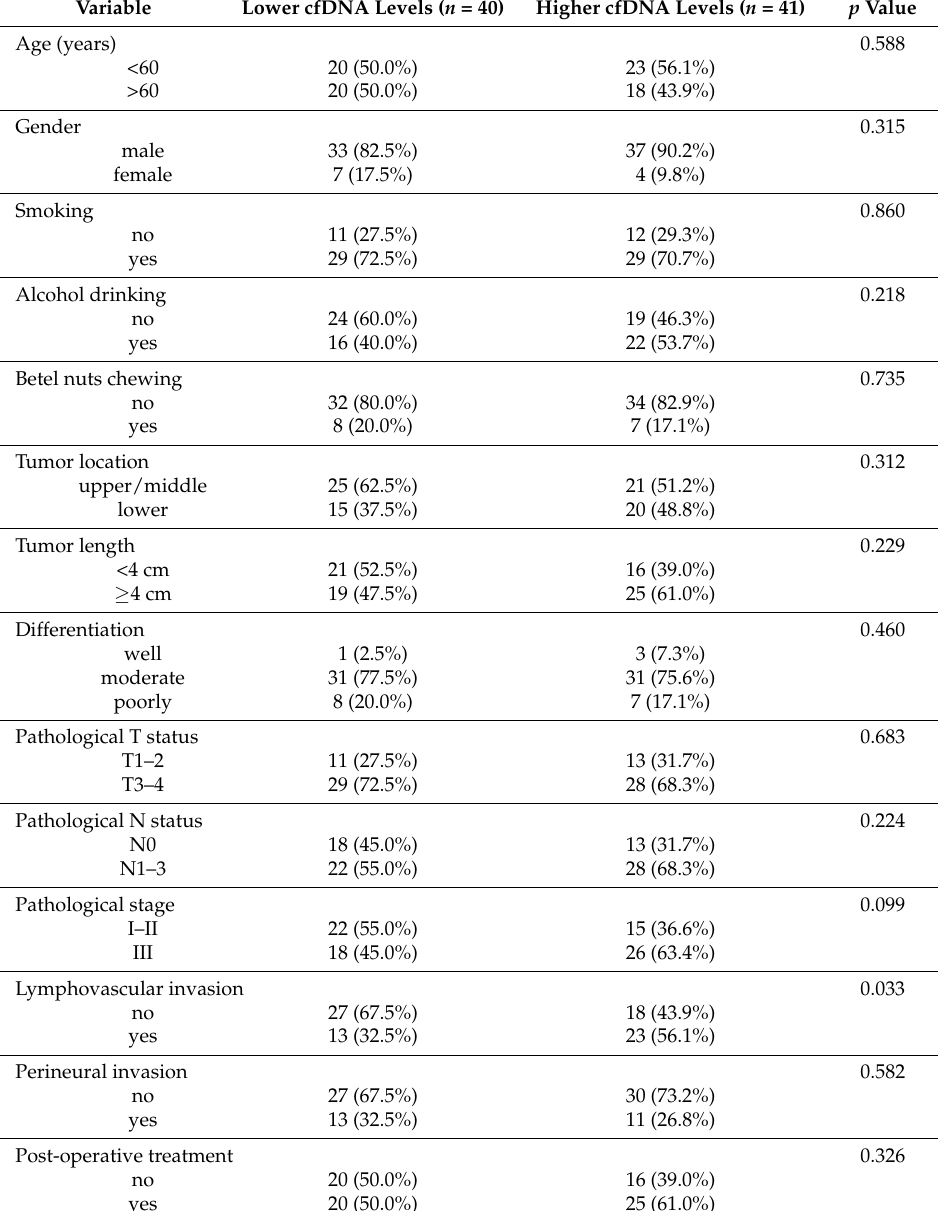
Table 1. Comparison of clinocopathological parameters between patients with lower cell-free DNA (cfDNA) and higher cfDNA